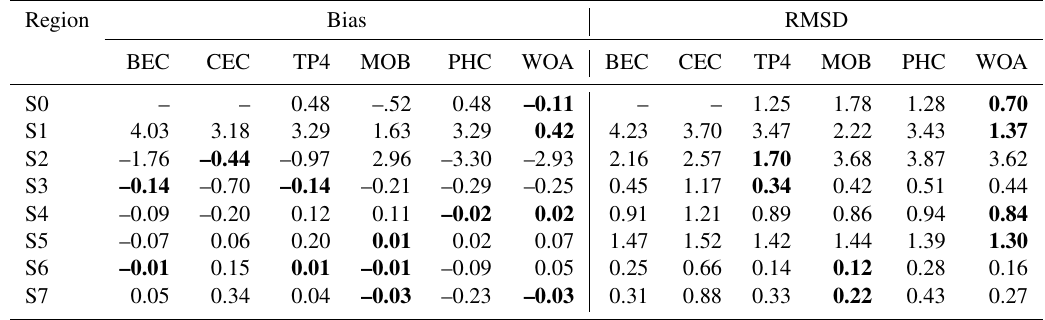
Table 2. Misfits of SSS (unit: psu) relative to in situ observations (CORA5.1) during 2011–2013 in each sub-region. Bold numbers denote the smallest error among the six products.